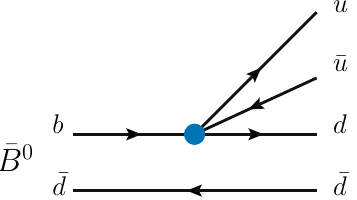
Fig. 2 The tree-level b → u ¯ ud weak transition, where the blue blob represents the short-distance internal W -boson emission ¯ d γ μ ( 1 − γ 5 ) T a u ¯ u γ μ ( 1 − γ 5 ) T a b we have O 1 = O 2 / N c + 2 with T a the Gell-Mann matrices.